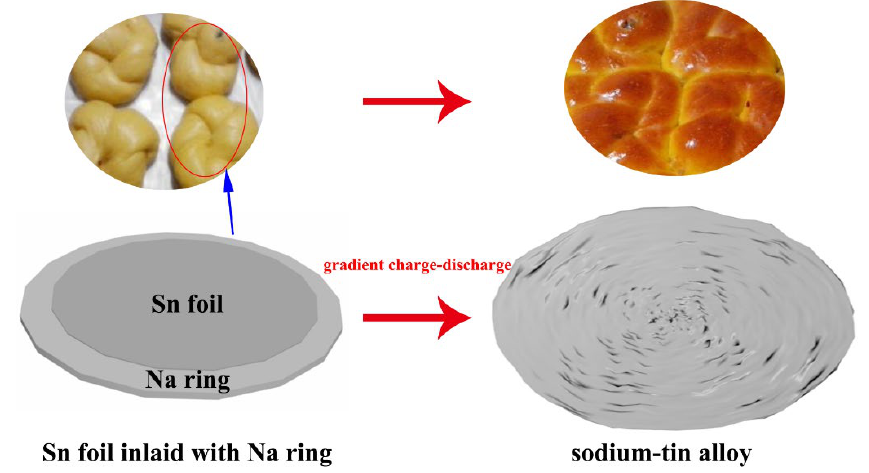
Figure 1. The schematic illustration for in situ electrochemical derivation of sodium-tin alloy.